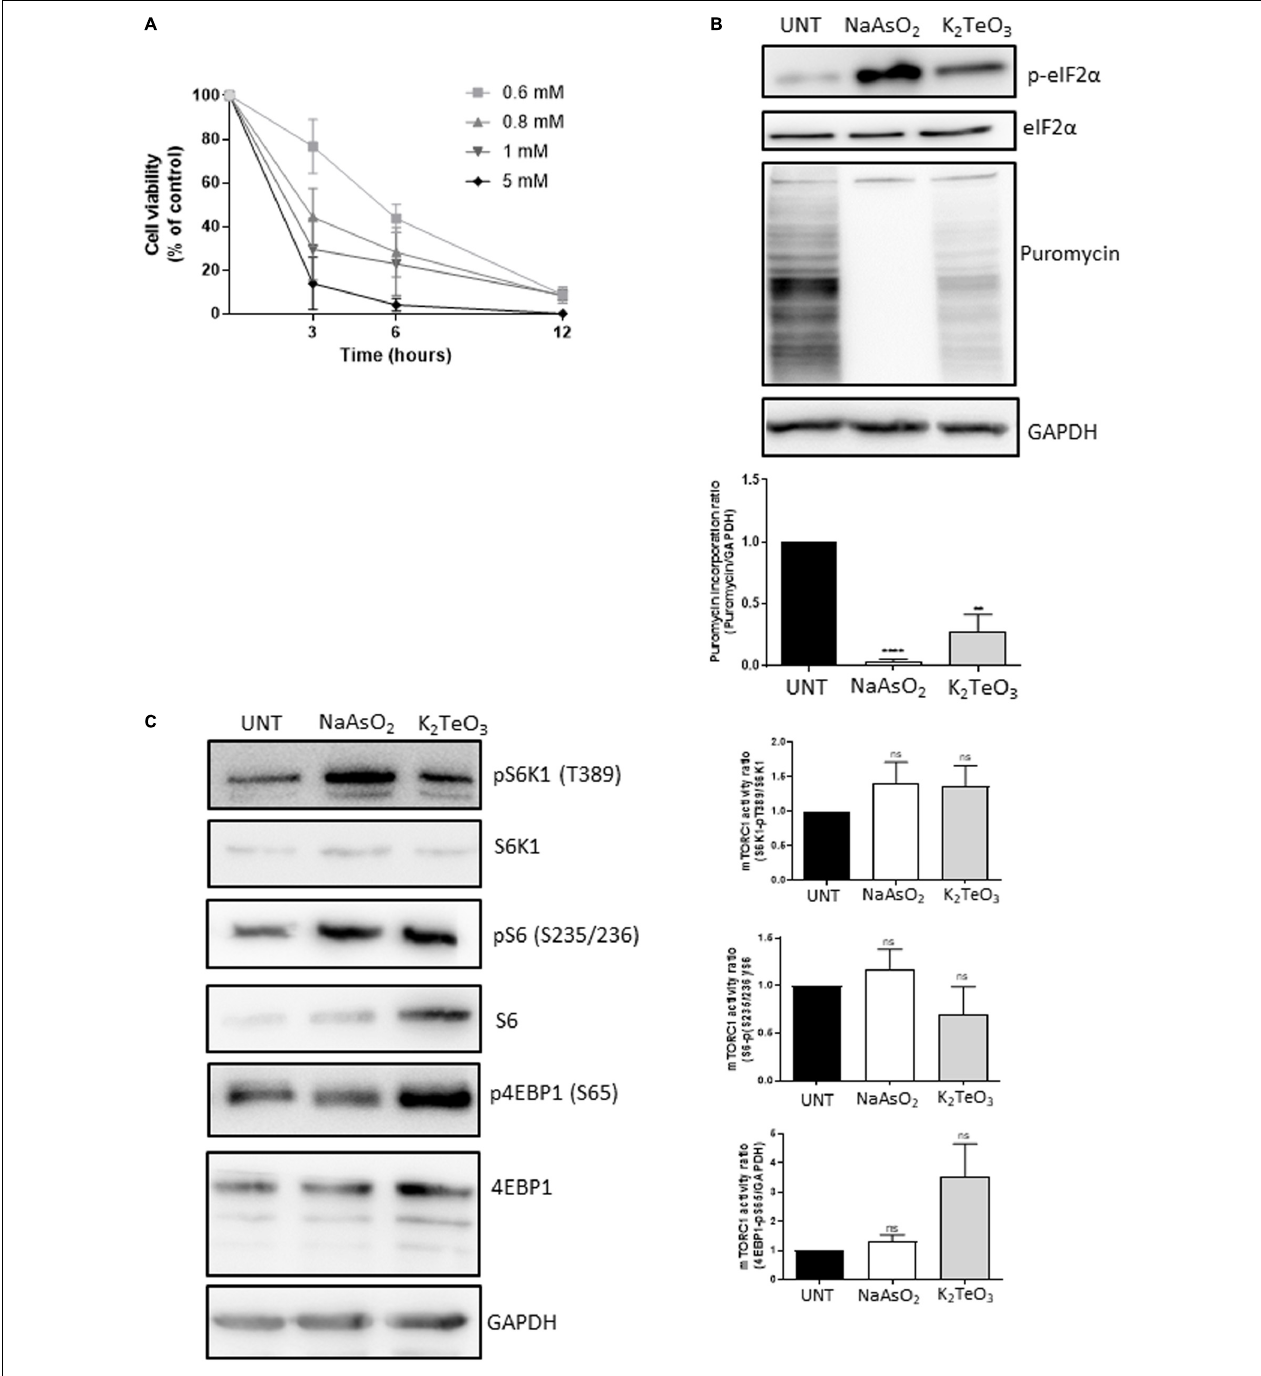
FIGURE 1 | Effect of tellurite on U2OS GFP-G3BP-1 cell viability. (A) Cells were treated with 0.6, 0.8, 1, 2, or 5 mM tellurite (K 2 TeO 3 ) for 3, 6, or 12 h. Subsequently, cell viability was evaluated using the MTT assay. Cell viability is represented as a percentage of the untreated condition. Mean ± SD from 3 independent experiments is shown. (B) Tellurite induces eIF2 α phosphorylation and global translational arrest. U2OS GFP-G3BP-1 cells were treated with 0.6 mM tellurite (K 2 TeO 3 ) for 3 h or with 0.3 mM arsenite (NaAsO 2 ) for 1 h as a positive control for eIF2 α phosphorylation and translational arrest. De novo protein synthesis was evaluated by puromycin incorporation and GAPDH was used as a loading control (upper panel). Puromycin pixel intensity was quantified by densitometry analyzes and normalized against GAPDH pixel intensity (bottom panel). Mean ± SD from 3 different is shown (**** p < 0.0001, ** p < 0.005 by unpaired t -test relative to untreated cells). (C) Global translational arrest is mTORC1-independent. U2OS GFP-G3BP-1 cells were treated with 0.6 mM tellurite (K 2 TeO 3 ) for 3 h or with 0.3 mM arsenite (NaAsO 2 ) for 1 h. The mTORC1 signaling was assesed by the phosphorylation status of its downstream targets S6K1, S6 and 4EBP1. GAPDH was evaluated as a loading control (upper panel). (Right panel) Ratio of pS6K1 (T389)/total S6K1 (upper panel), pS62 (35/236)/S6 total (middle panel) and p4EBP1 (S65)/GAPDH (bottom panel) were quantified by densitometry analyzes of figure (C) (bottom panel). Mean ± SD from 3 different is shown. ns p > 0.05 by unpaired t -test relative to untreated cells.